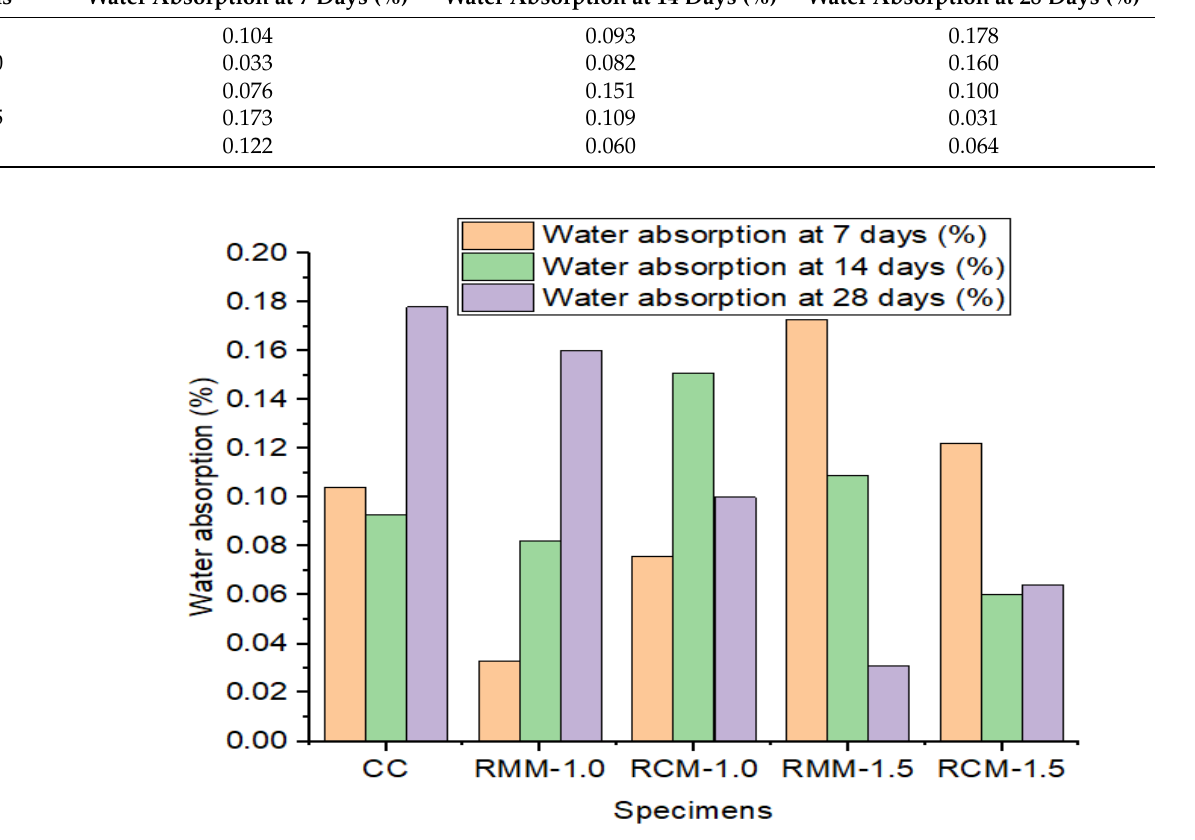
Figure 6. Chart showing the water absorption results of samples at 7, 14, and 28 days.